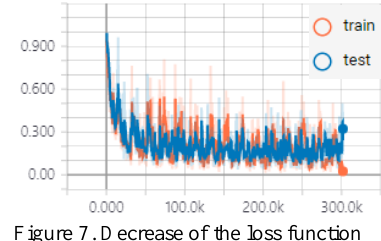
Figure 7. Decrease of the loss function